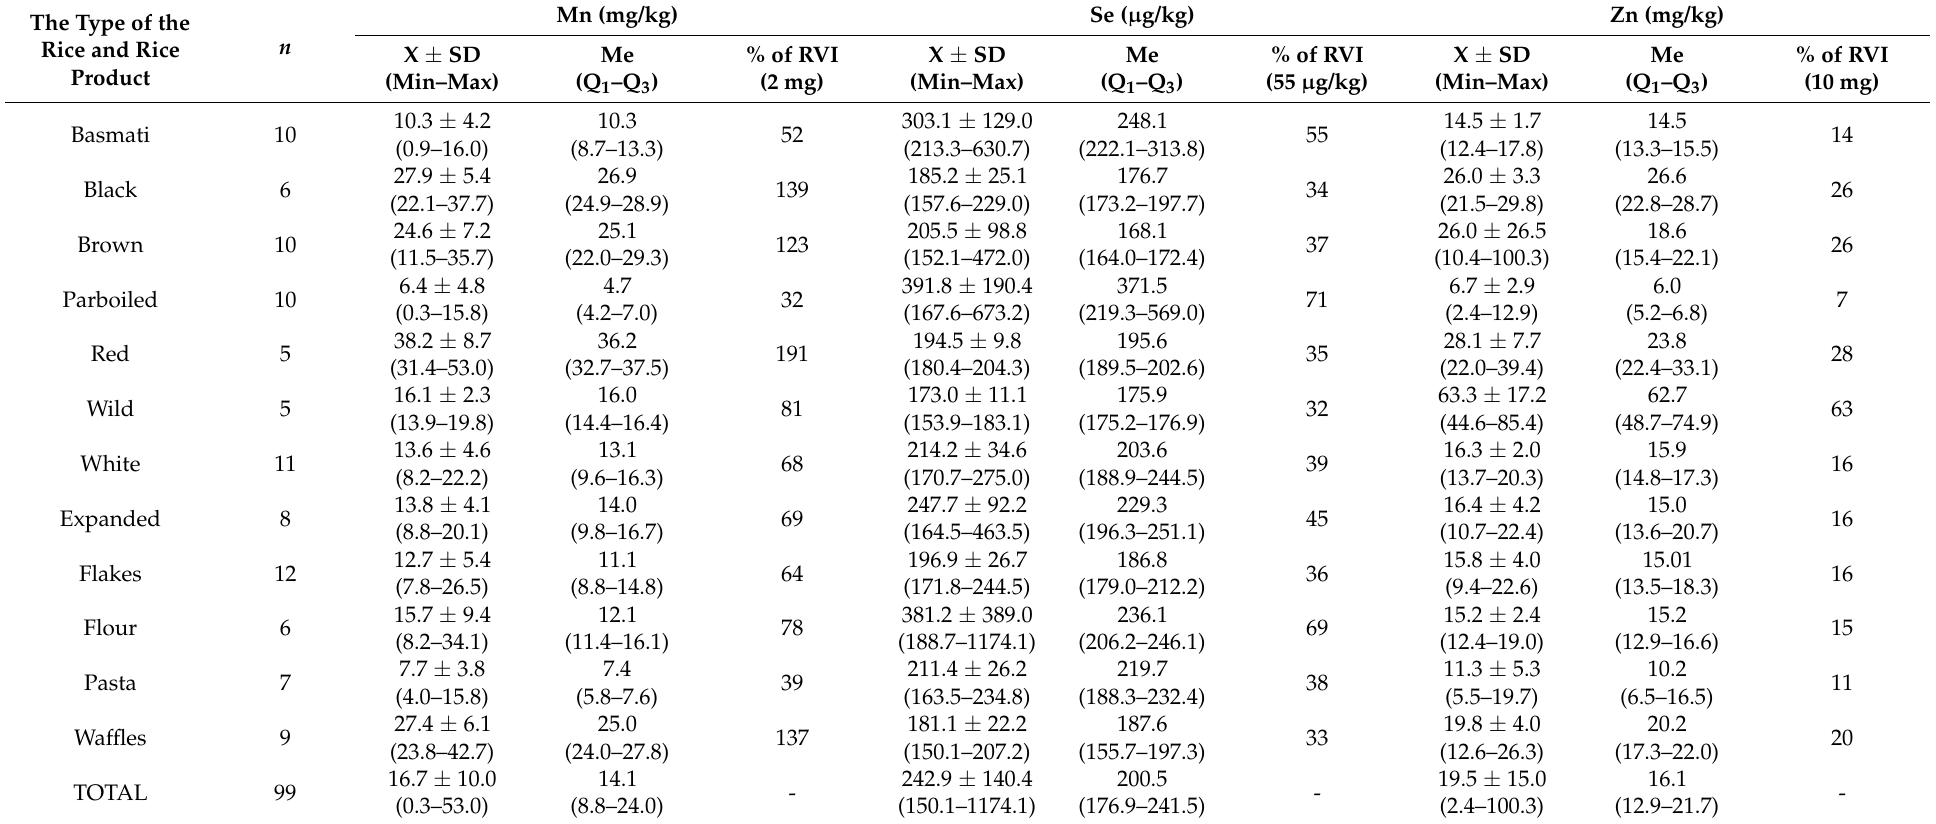
Table 4. The content of Mn, Se and Zn in rice and rice